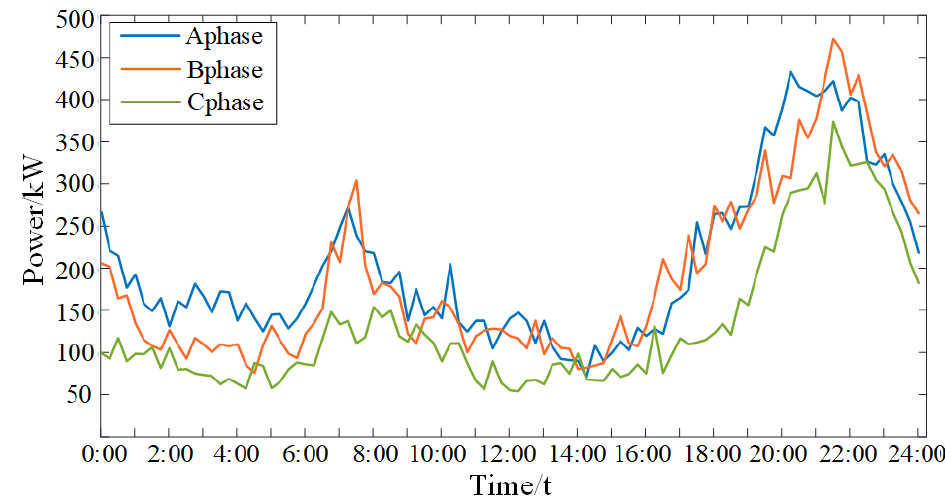
Figure 3. Daily load curve of distribution transformer in distribution area.